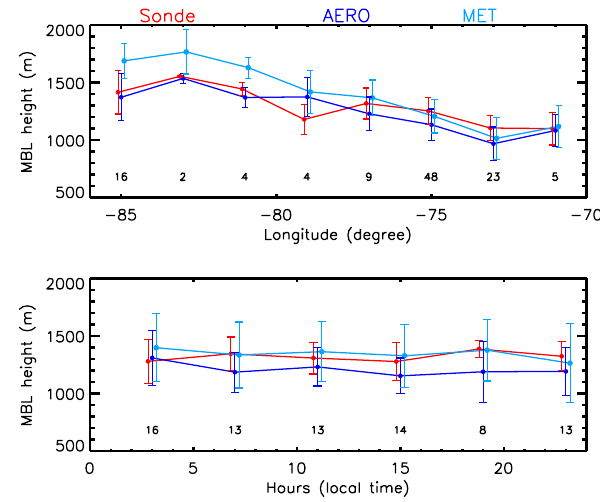
Fig. 2. Longitudinal and diurnal variations of the MBL heights de- rived from the RB radiosonde and BAe-146 dropsonde measure- ments (red), and from the AERO (blue) and MET (light blue) simu- lations. Only radiosonde profiles are included in the bottom panel. The MBL heights are determined from temperature profiles in com- bination with humidity profiles. The numbers of observational data used are indicated below the data